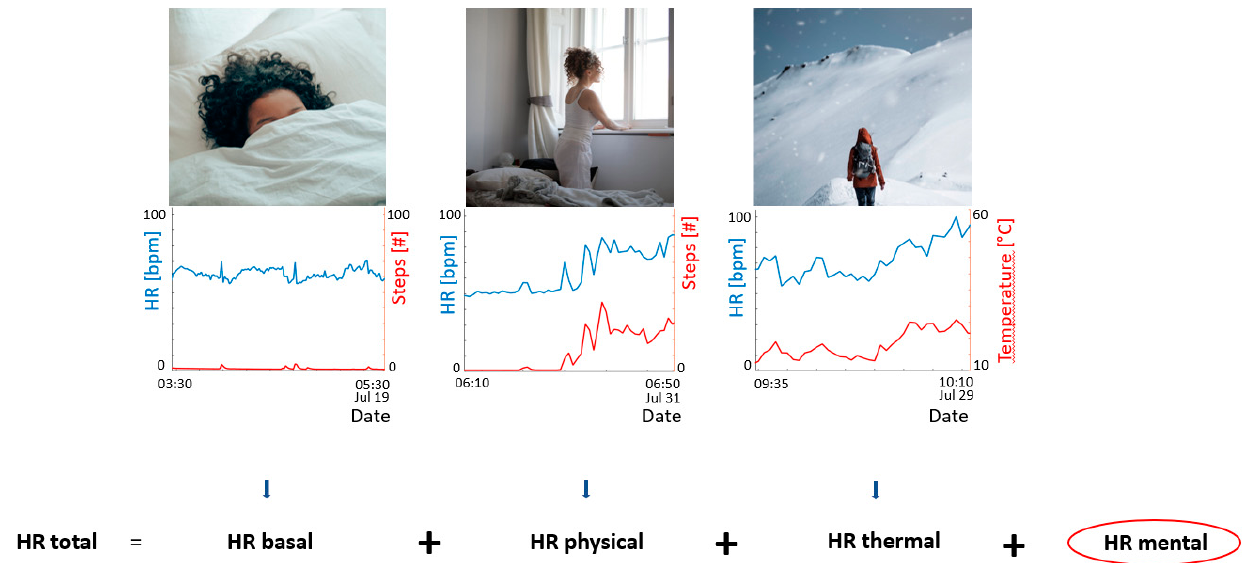
Figure 2. Total heart rate decomposed in the basal, the physical, the thermal and the mental compo-